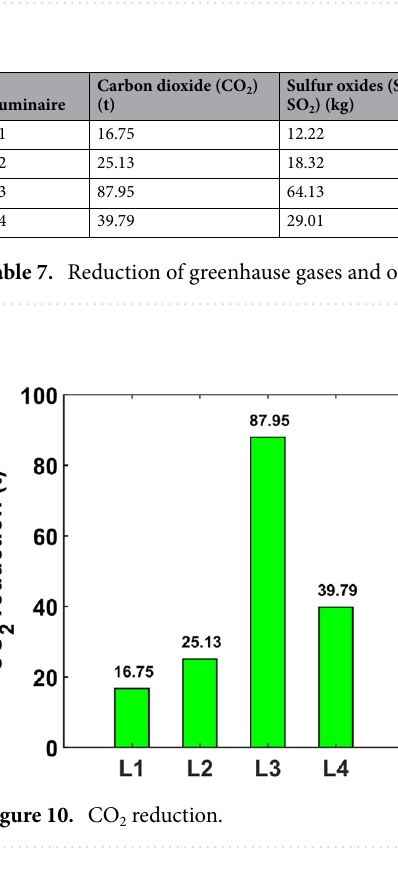
Figure 9. Total electricity saving.